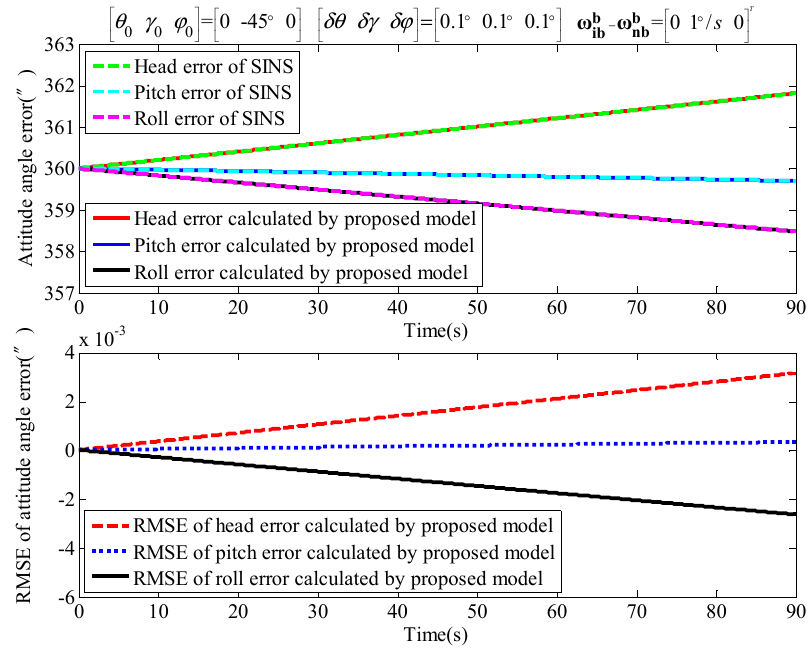
Figure 8. The Euler angle error propagation with coupling of three initial Euler angle errors and rotation in the X axis.